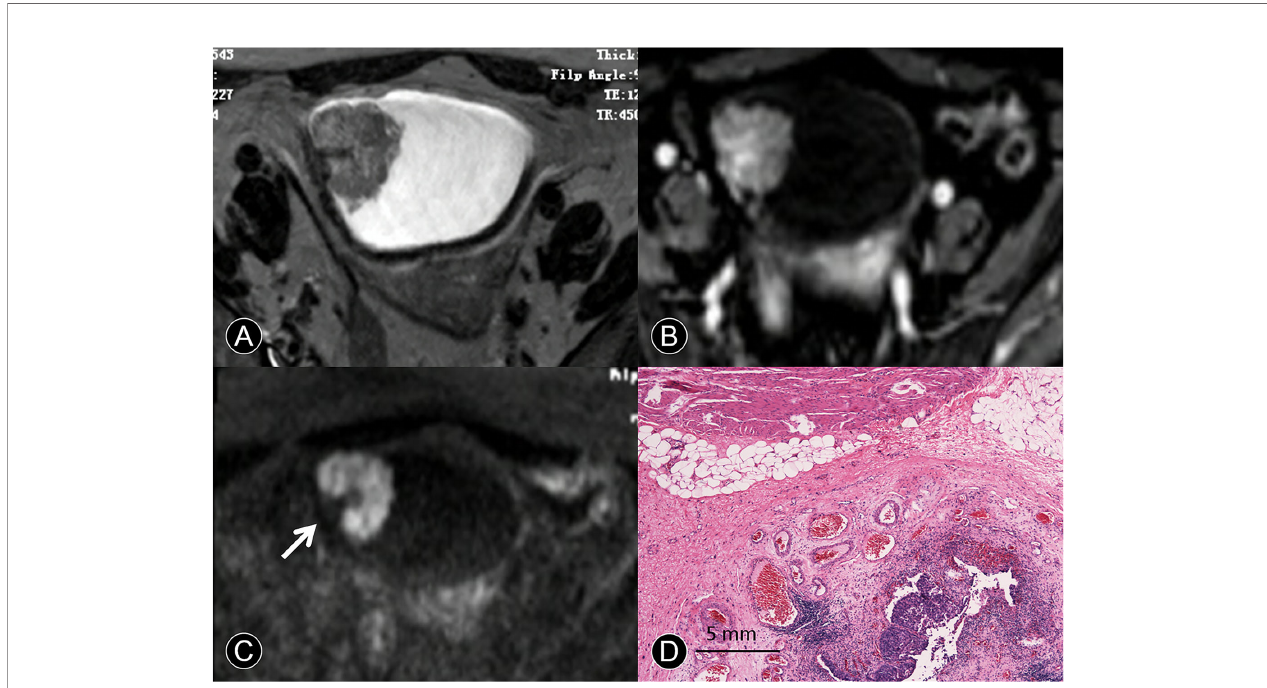
FIGURE 3 | MR images of a 65-year-old man with pT1 urothelial carcinoma. (A) The transverse T2 SPAIR image shows an oval mass on the right discontinuous bladder wall without obvious a C-shaped high SI area (arrow). (B) The transverse DCE image shows an oval mass that is enhanced, the central part of the mass is signi fi cantly enhanced, and the submucosa is slightly enhanced without obvious a C-shaped high SI area (arrow). (C) The transverse DW MR image shows a C-shaped high SI area with a low SI stalk connecting to the right side of the bladder wall with a wide base contact area (arrow). (D) The photomicrograph of a specimen shows papillary cancer invading the submucosa (Hematoxylin-eosin staining; original magni fi cation,